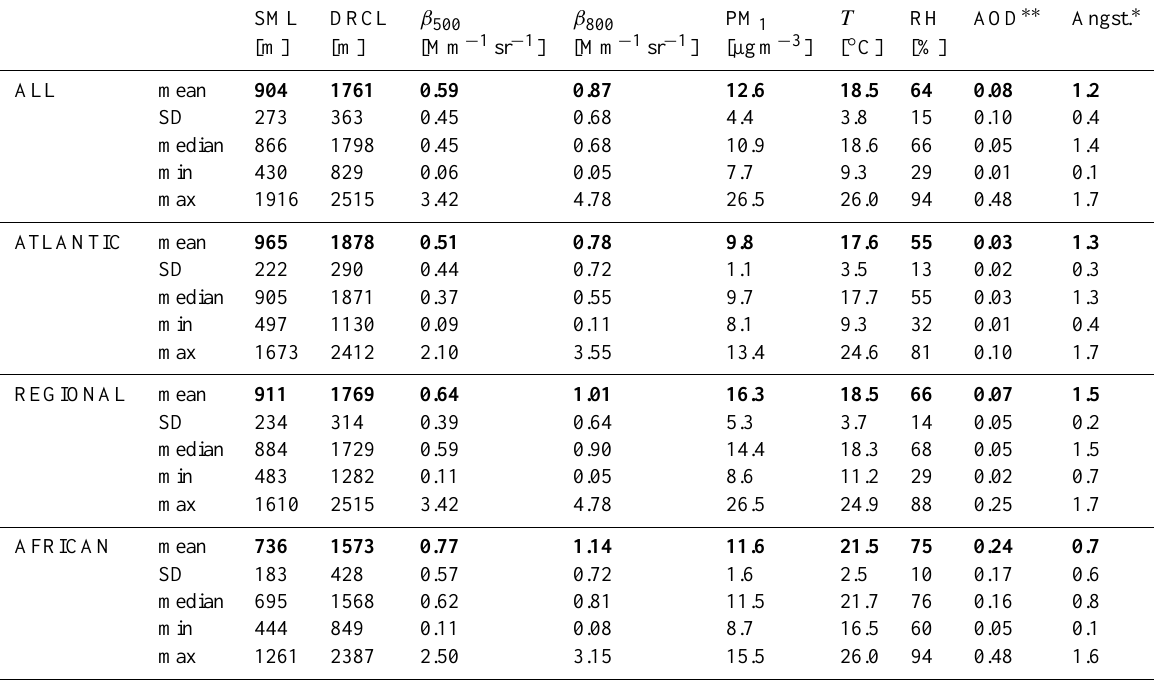
Table 1. Characteristics of measurements and variables presented in this work for the whole SAPUSS campaign (ALL) and for each scenario identified during SAPUSS, namely: African, Atlantic, and Regional. Mean values highlighted in bold indicate the variables for which a significant difference was observed among the three different scenarios. SD: standard